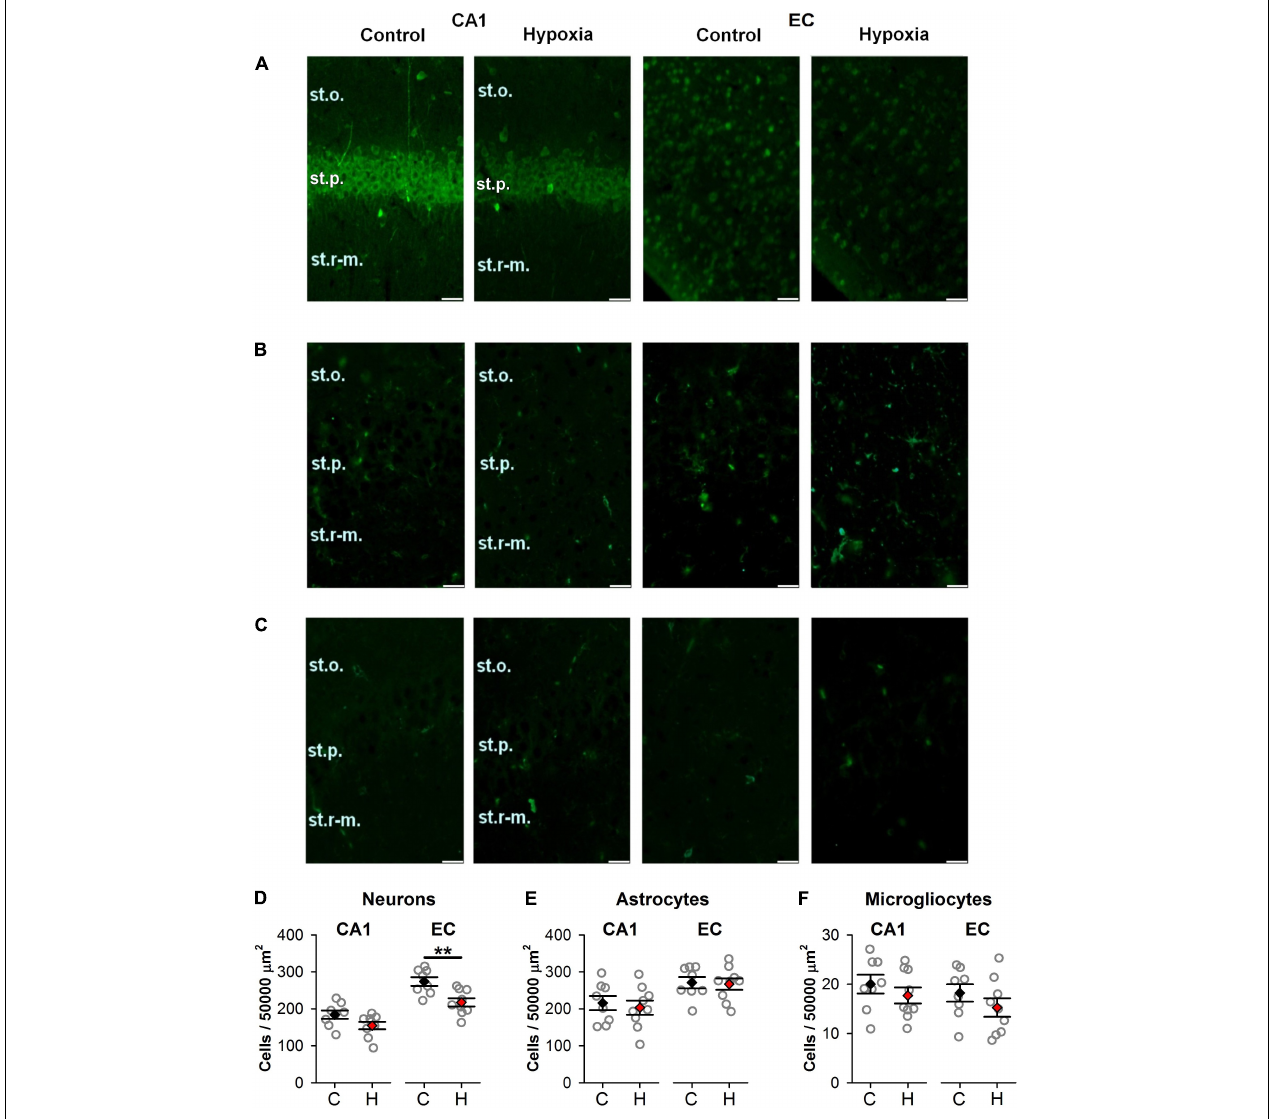
FIGURE 2 | The effect of prenatal hypoxia on the number of neurons and glial cells in the CA1 area of the dorsal hippocampus and entorhinal cortex (EC). (A–C) Micrographs of the deep layers of the EC and st. pyramidale of CA1 area of hippocampus in control and “hypoxic” rats. Immunofluorescence (green) of neuronal marker protein NeuN (A) , astrocytic marker GFAP (B) , and microglia marker Iba1 (C) . st.p, stratum pyramidale; st.o, stratum oriens; st.r-m, stratum radiatum-moleculare. Scale bar—50 µ m. (D–F) The average number of cells in the CA1 area (CA1) of the dorsal hippocampus and EC (EC): NeuN-positive neurons (D) , GFAP-positive (E) , and Iba1-positive (F) glial cells in control ( n = 8) and hypoxic rats ( n = 9). Values are presented as mean ± standard error of the mean. The difference between hypoxic and control (black) groups was determined by Student’s t -test (** P <